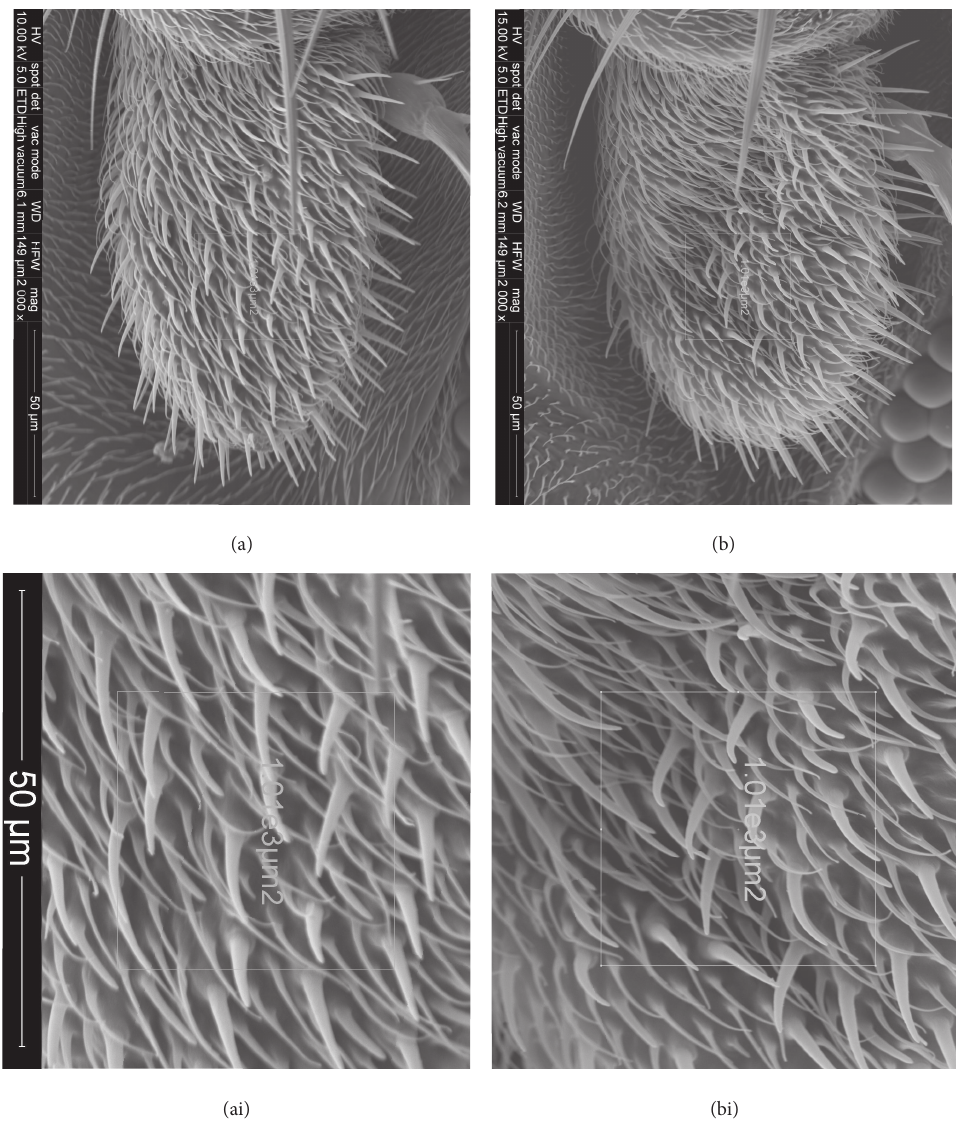
Figure 5: Scanning electron micrographs of flagellum of D. melanogaster WT (a) and LRRK WD 40 mutant (b); (ai and bi) the respective magnifications of the central area with the frame used to count the density of sensilla.